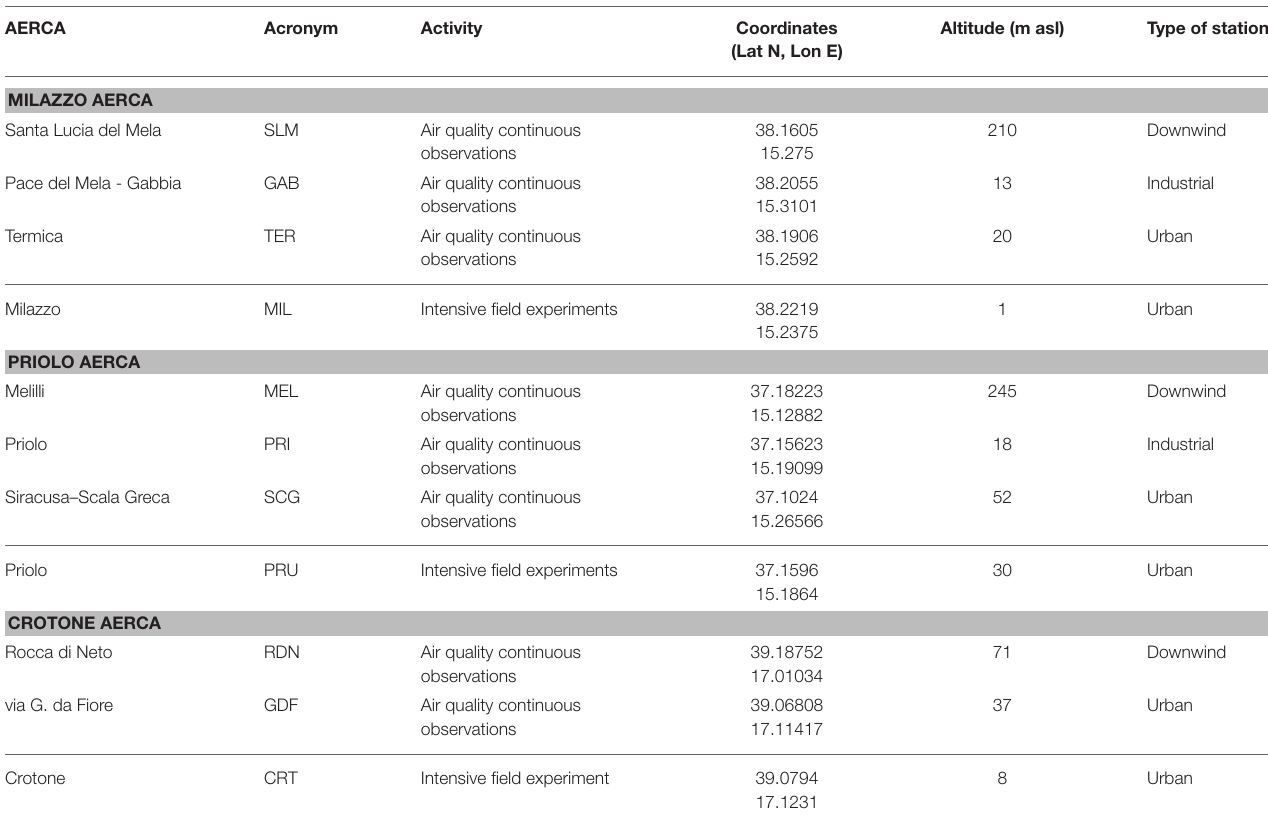
TABLE 1 | List of monitoring sites included in the present study.